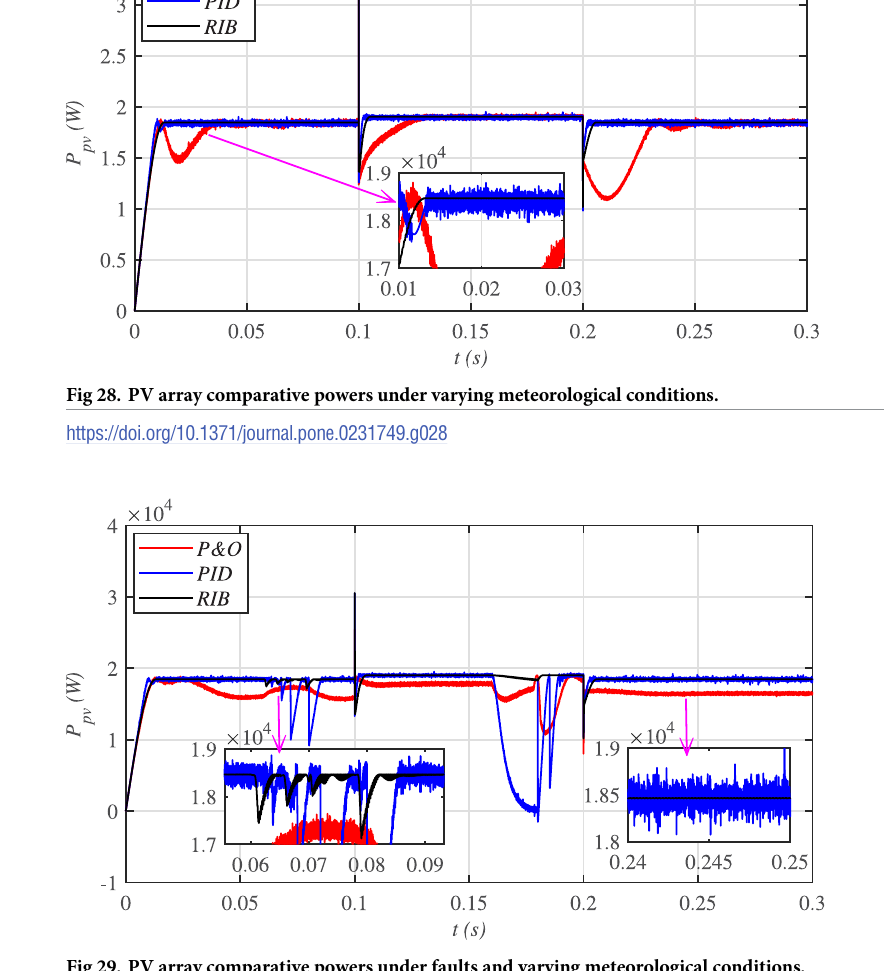
Fig 29. PV array comparative powers under faults and varying meteorological conditions.